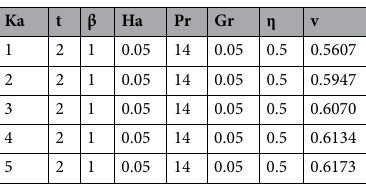
Table 4. Finite difference scheme results of velocity for different values of ka.